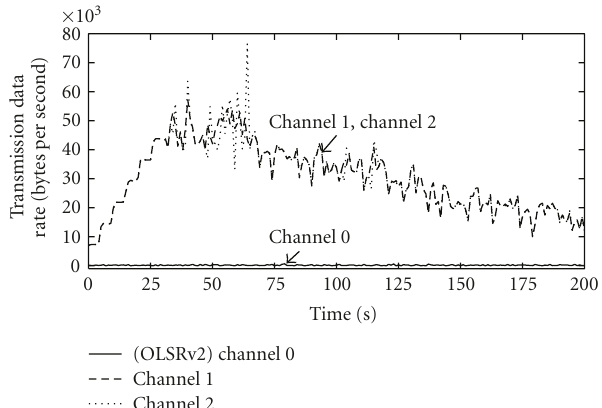
Figure 19: Transition of CPU usage at node